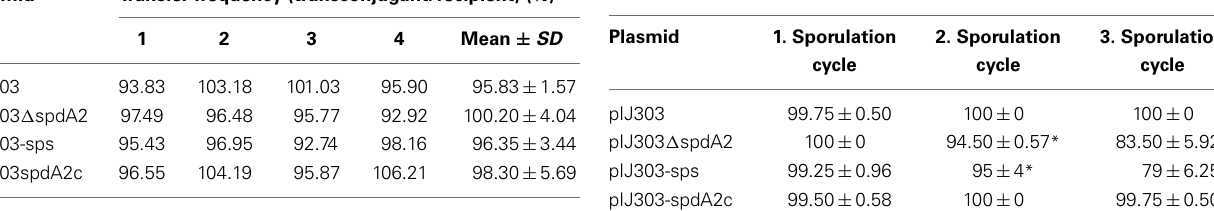
Table 4 | Influence of spdA2/sps on plasmid stability (percentage of plasmid content).